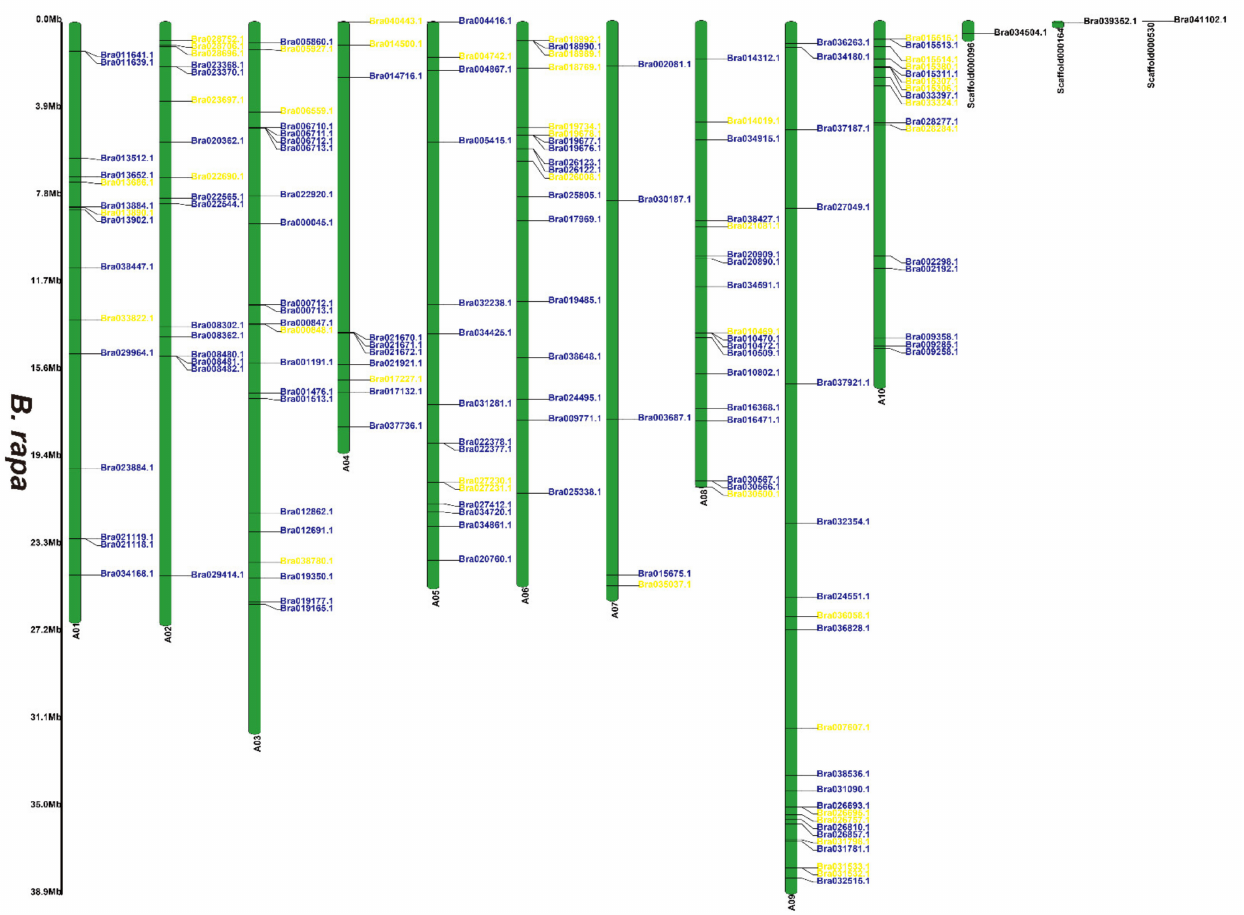
Figure 2. Chromosomal distribution of putative 2OGDs in B. rapa . Individual 2OGD positions are shown in Mbs along the chromosome scale. The blue label represents the retained gene, the yellow label represents the lost